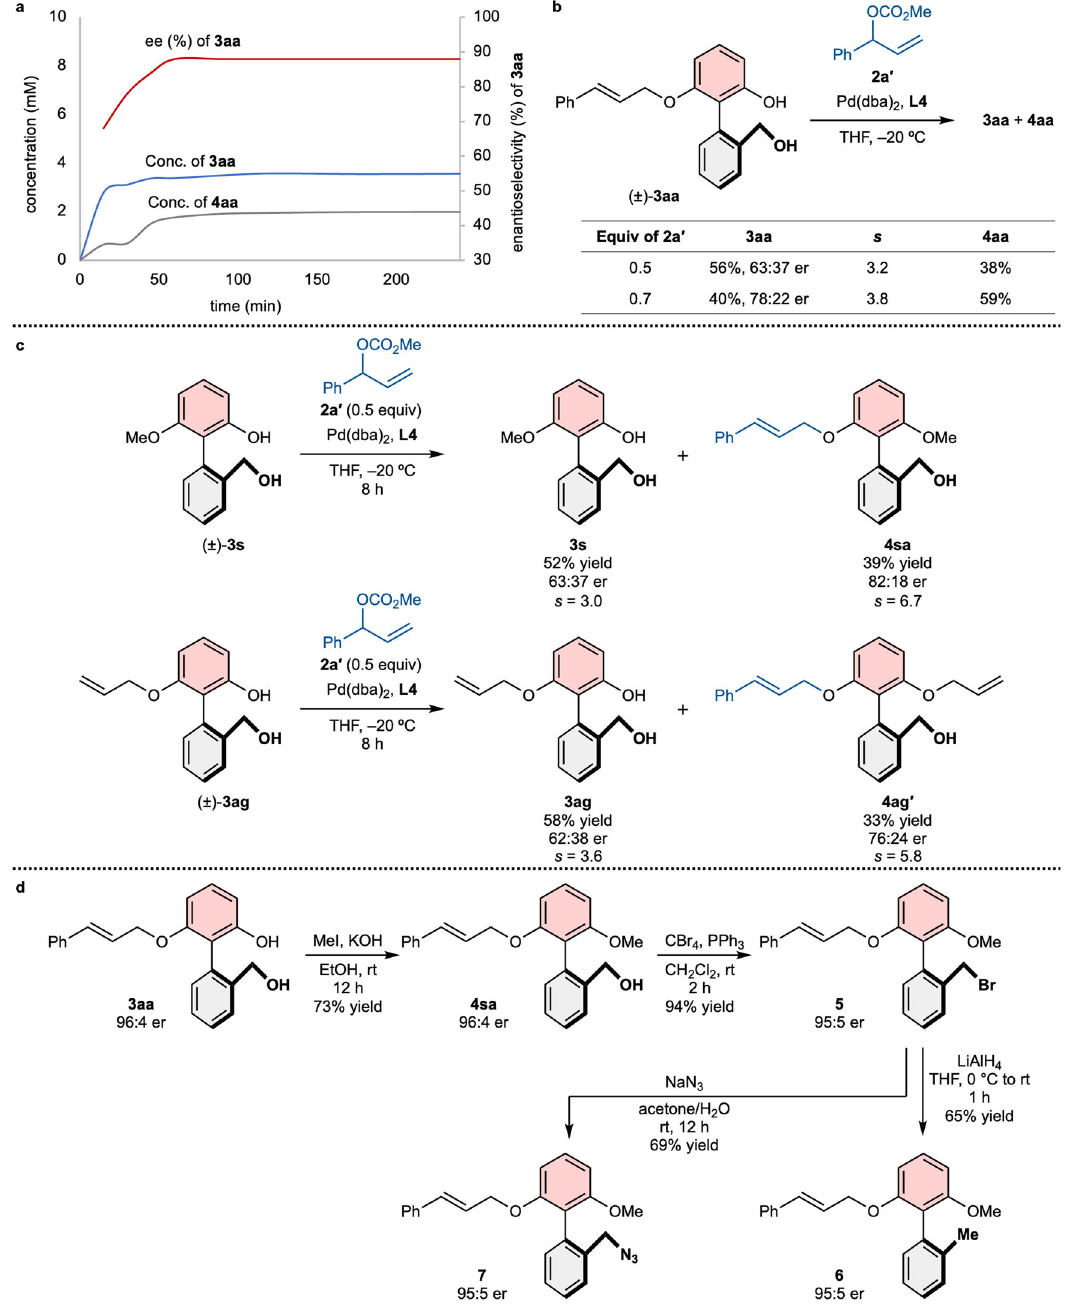
Fig. 4 Reaction pro fi le, kinetic resolution effects, and further transformations. a Reaction conversion and product distributions. b Secondary kinetic resolution effects of 3aa . c Atroposelective allylation via kinetic resolution. d Further